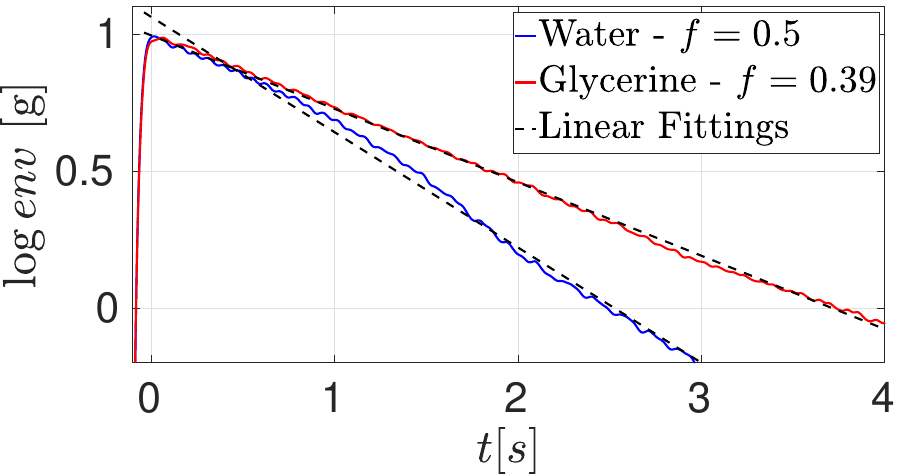
Figure 3. Logarithm of the envelope function and performed linear fitting for water and glycerine tests at f = 0.5 and f = 0.39, respectively; y 0 / H = 1 and λ =